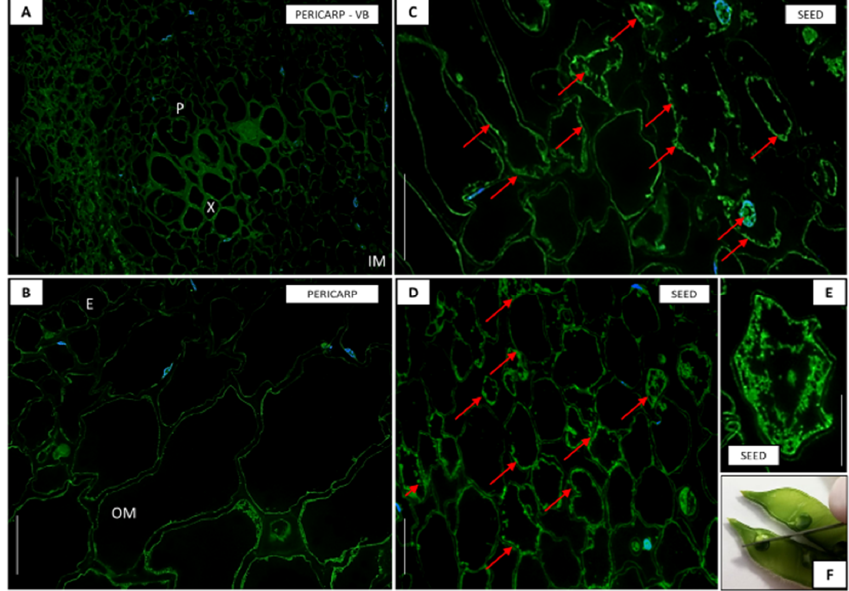
Figure 10. Tissue and cellular localization of gibberellic acid (GA 3 ) ( A – E ) in the late phase (8P; F ) of pericarp and seed development in yellow lupine. A higher level of GA 3 was detected in the seeds ( C,D,E ) than in the pericarp ( A,B ). The green fluorescence signal was mainly observed near the walls of the seed cells ( C,D ) and only in some cells were the signal distributed throughout the cytoplasm ( E ). In pericarp, the presence of GA 3 was not observable for epidermis (E), outer mesocarp (OM), and inner mesocarp (IM) cells, as well as conductive bundles (P—phloem, X—xylem) ( A,B ). Red arrows indicate the localization of GA 3 . DAPI was used for nuclei staining. Scale bars: 50 µ m (A,B), 30 µ m (C,D), 20 µ m